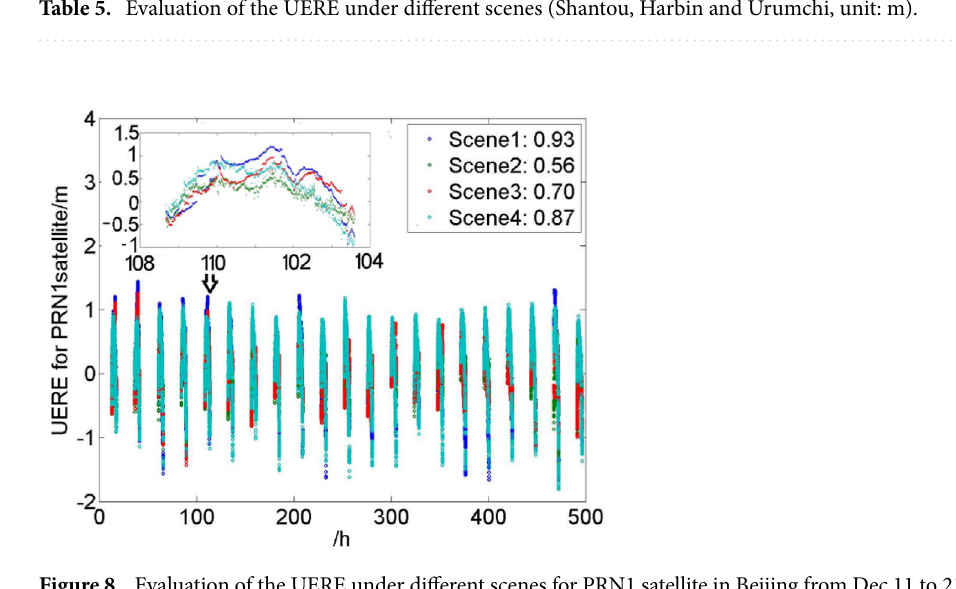
Figure 8. Evaluation of the UERE under different scenes for PRN1 satellite in Beijing from Dec 11 to 21,